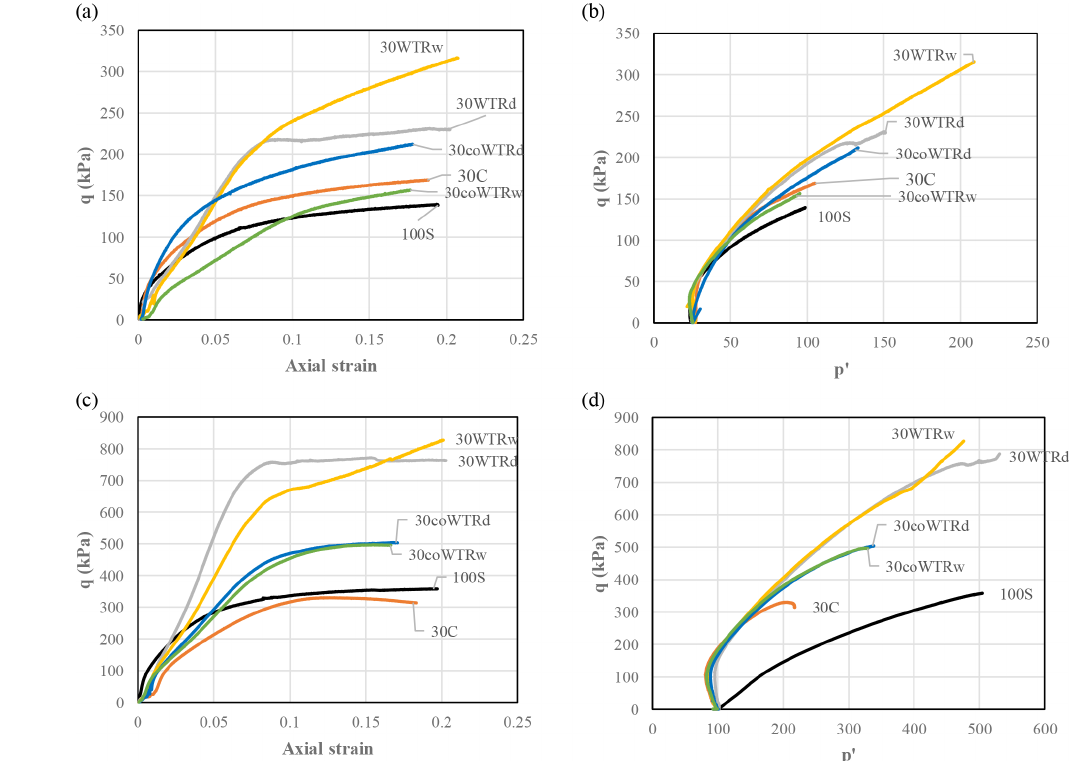
Figure 5. Panels (a) and (b) show the stress–strain response and stress paths for undrained triaxial tests carried out for a confining stress of 25kPa, and panels (c) and (d) show the same information for tests carried out for a confining stress of 100kPa.